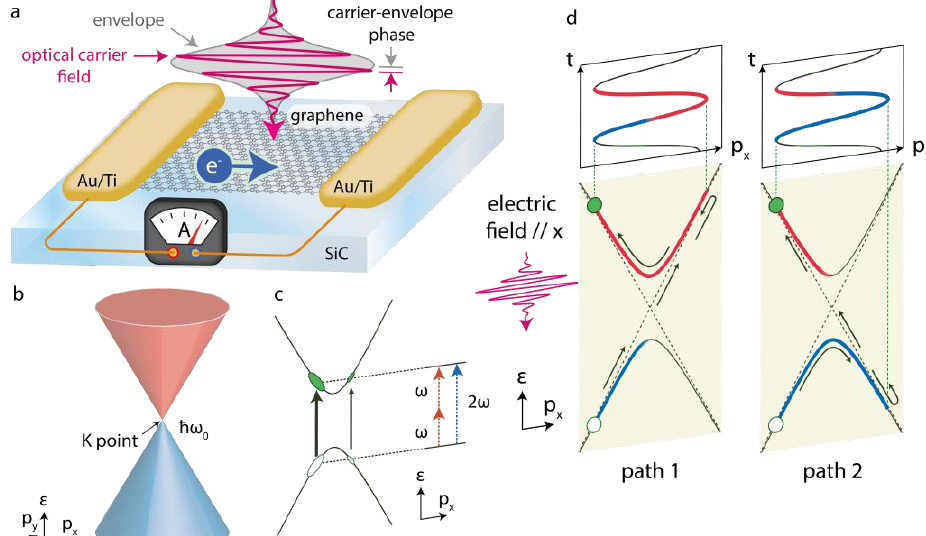
Fig. 1. a , A graphene stripe on SiC is illuminated by CEP-stabilized laser pulses. The laser- induced current flowing through the graphene stripe, contacted with Au/Ti electrodes, is measured. b , Dirac cone of graphene, with the conduction- (red) and the valence- band (blue). c , Perturbative one-photon and two-photon interference responsible for the CEP-dependent current generation in the weak-field regime. d , In the field-driven regime interband transitions are well described as repeated Landau-Zener transitions. Starting from the valence band, the electron may first diabatically tunnel to the conduction band and then adiabatically pass the splitting event (path 1), or vice versa (path